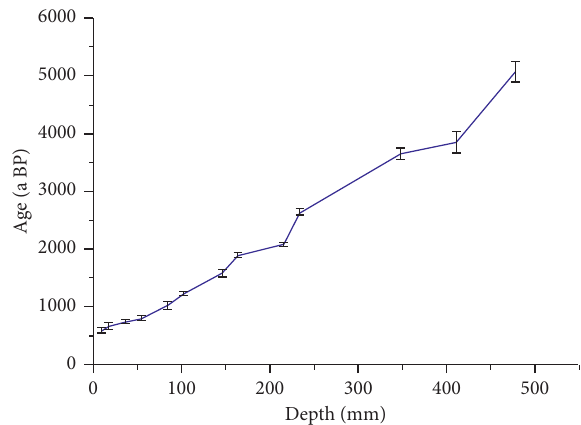
Figure 2: The age model of stalagmite ND3 in Naduo Cave (linear